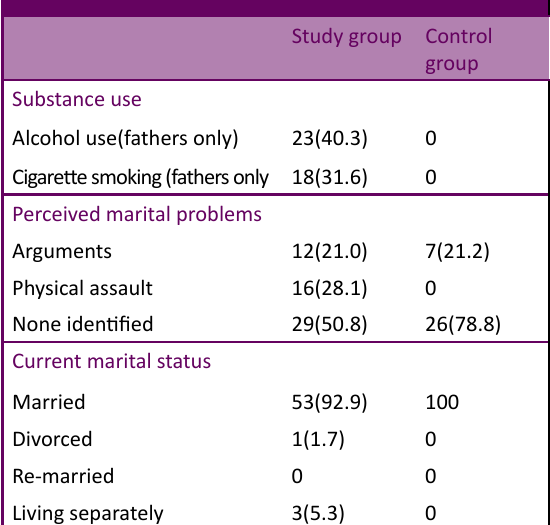
Study group Control